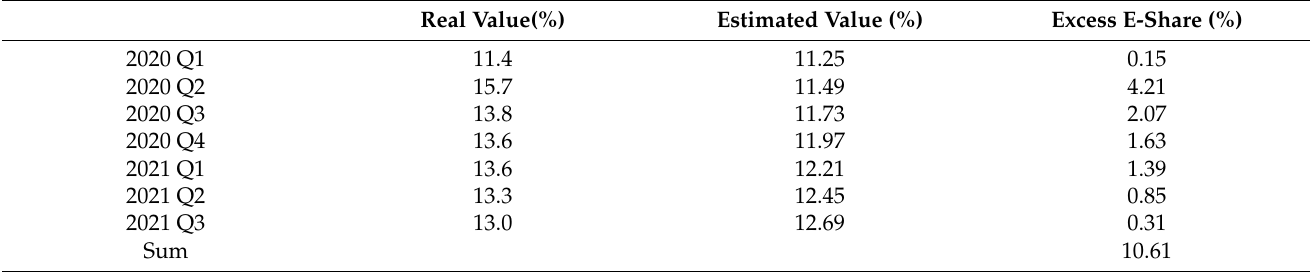
Table 4. Excess e-commerce retail sales as a percent of total sales over the pandemic window